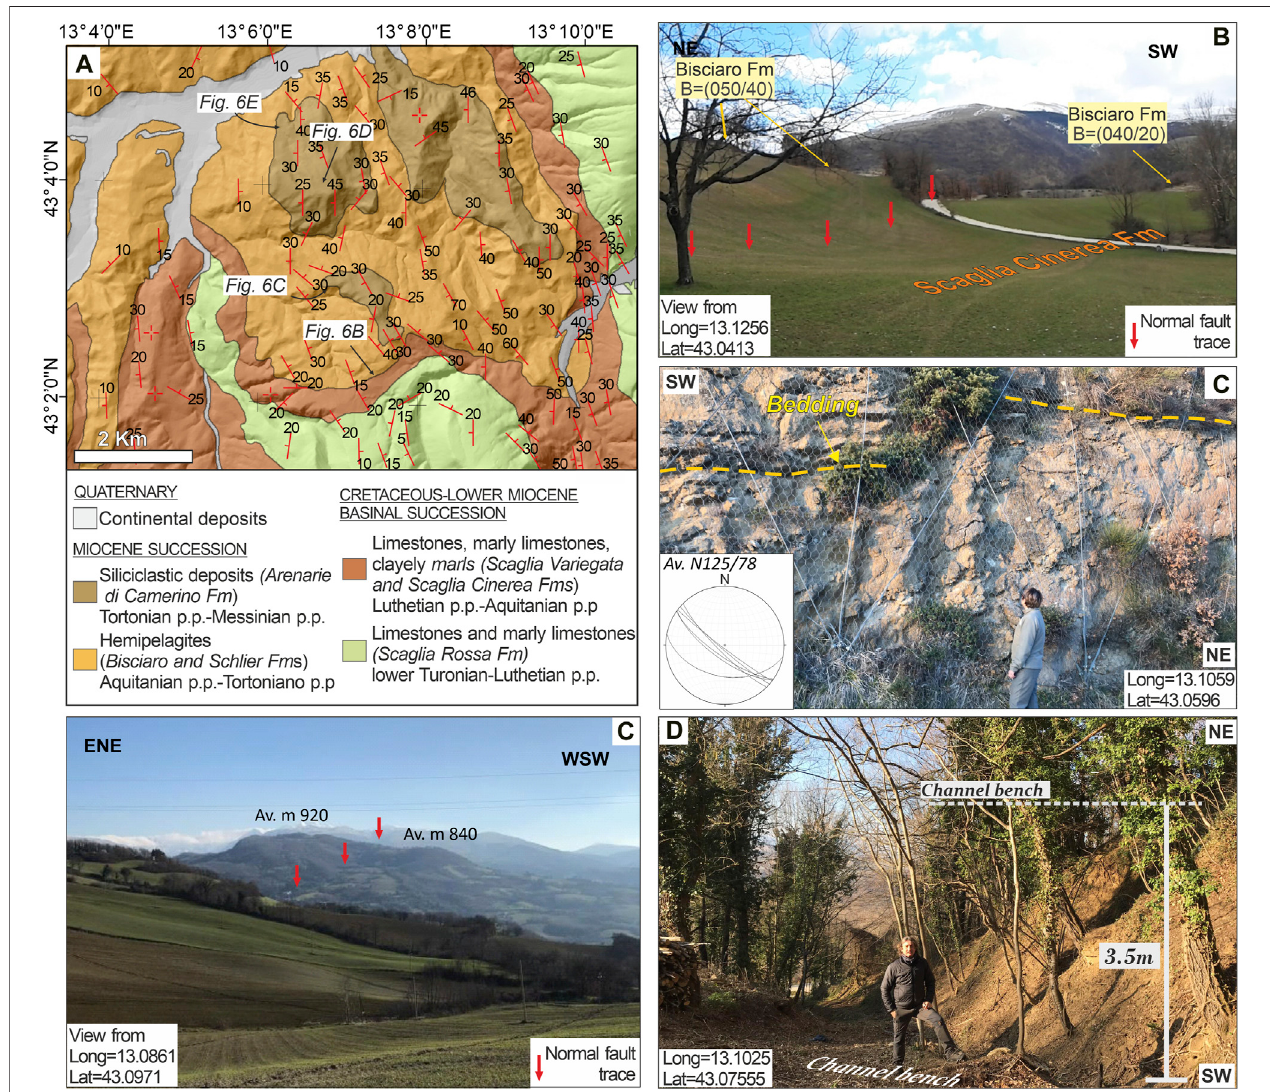
FIGURE6| Field survey and evidence ofnormal faulting collectedin thePievebovigliana-Fiastra sector (insetc in Figure 1B ). (A) Geological map ofthesector with the main outcropping stratigraphic units as derived from Carta Geologica d ’ Italia at scale 1:100,000 (Regio Uf fi cio Geologico, 1941; Servizio Geologico d ’ Italia, 1967). Labels point to the photographs shown in panels (B – E) . (B) Evidence of normal faulting showing the offset toward the south-west of the Bisciaro formation. (C) Meso- faults affecting the Arenarie di Camerino Fm causing discontinuities of the layers and juxtaposing intervals characterized by different sandstone/pelite ratio. (D) Lowering to SW (view from NNW) of the fl at surface standing on the Arenarie di Camerino Fm (see details in the text). (E) Metric offset affecting channel-bordering benches.Thelocationinlongitudeandlatitude(projectionWGS84/UTM33N)isalsoreportedforeachoutcrop.Noticetheabsenceofthenew-surveyedfaultevidencein the available map from the literature – (A)